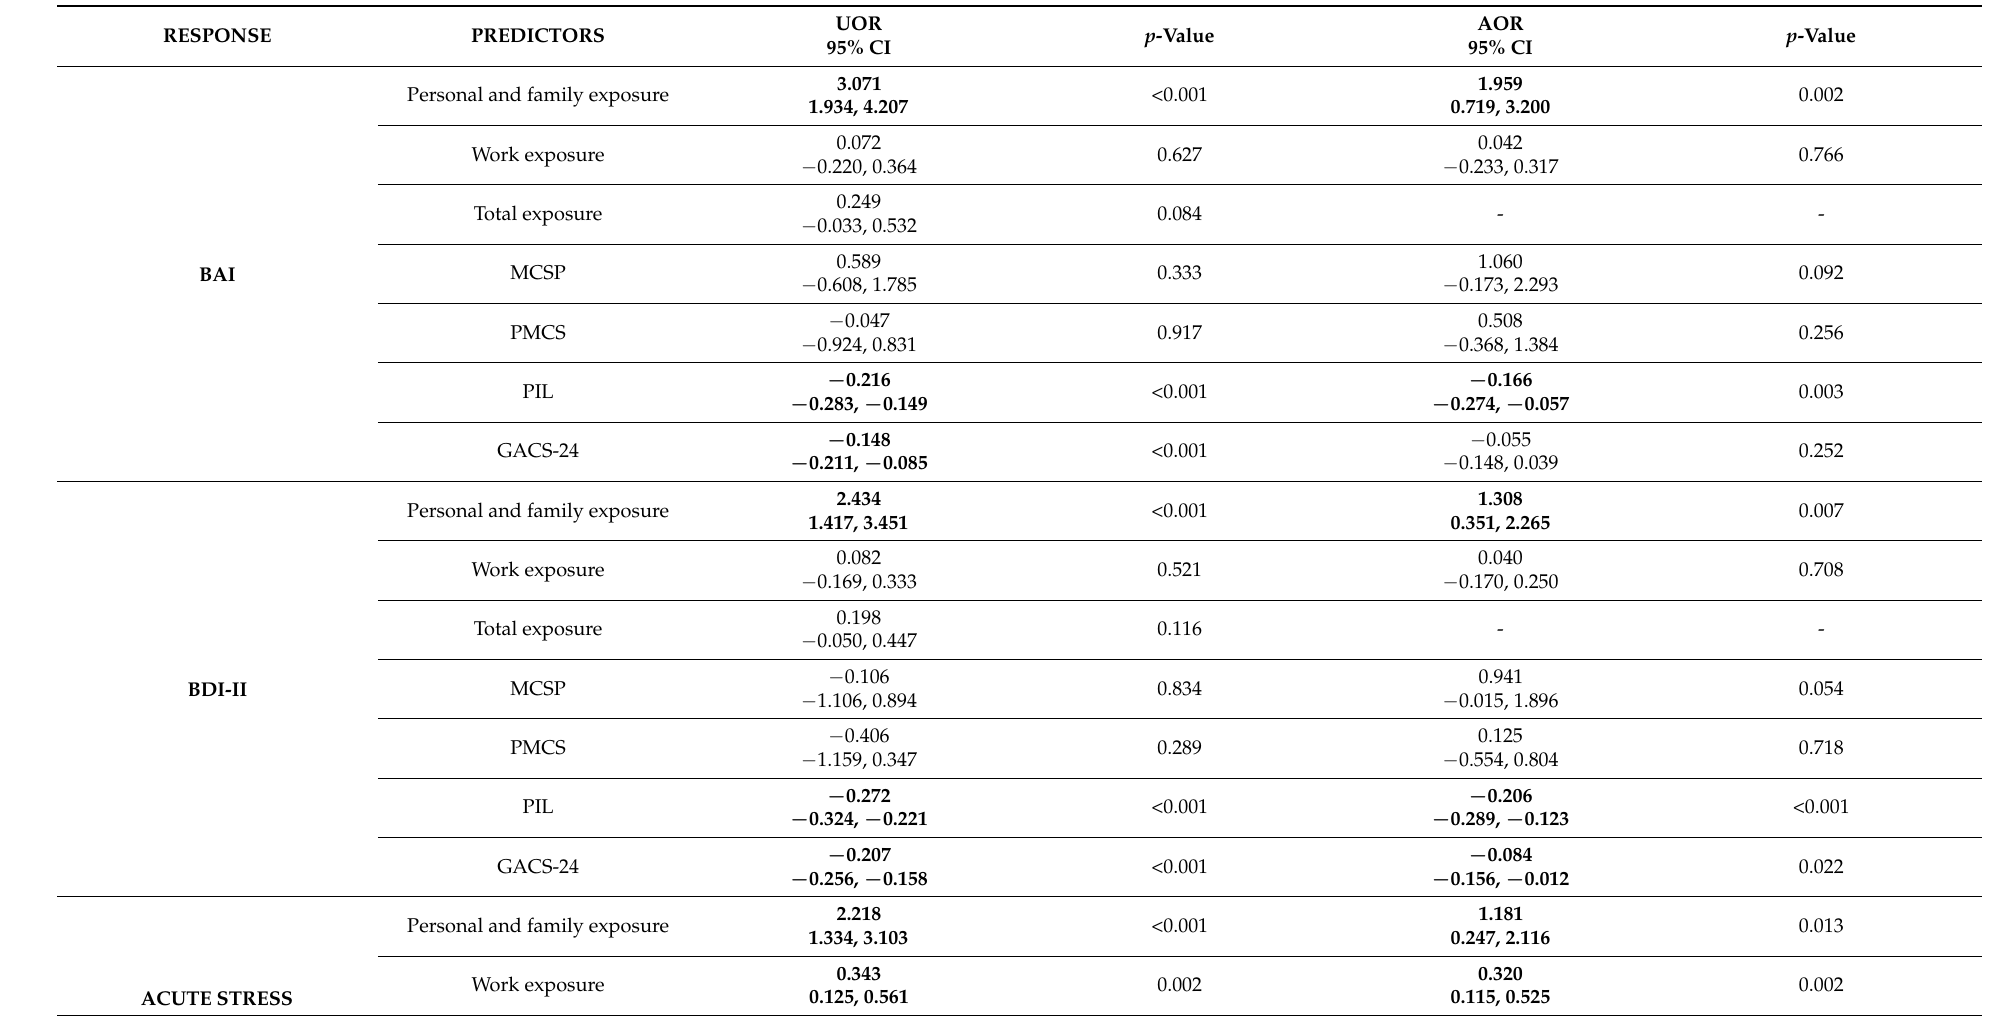
Table 3. Odds ratios from unadjusted and adjusted generalized linear models predicting dependent